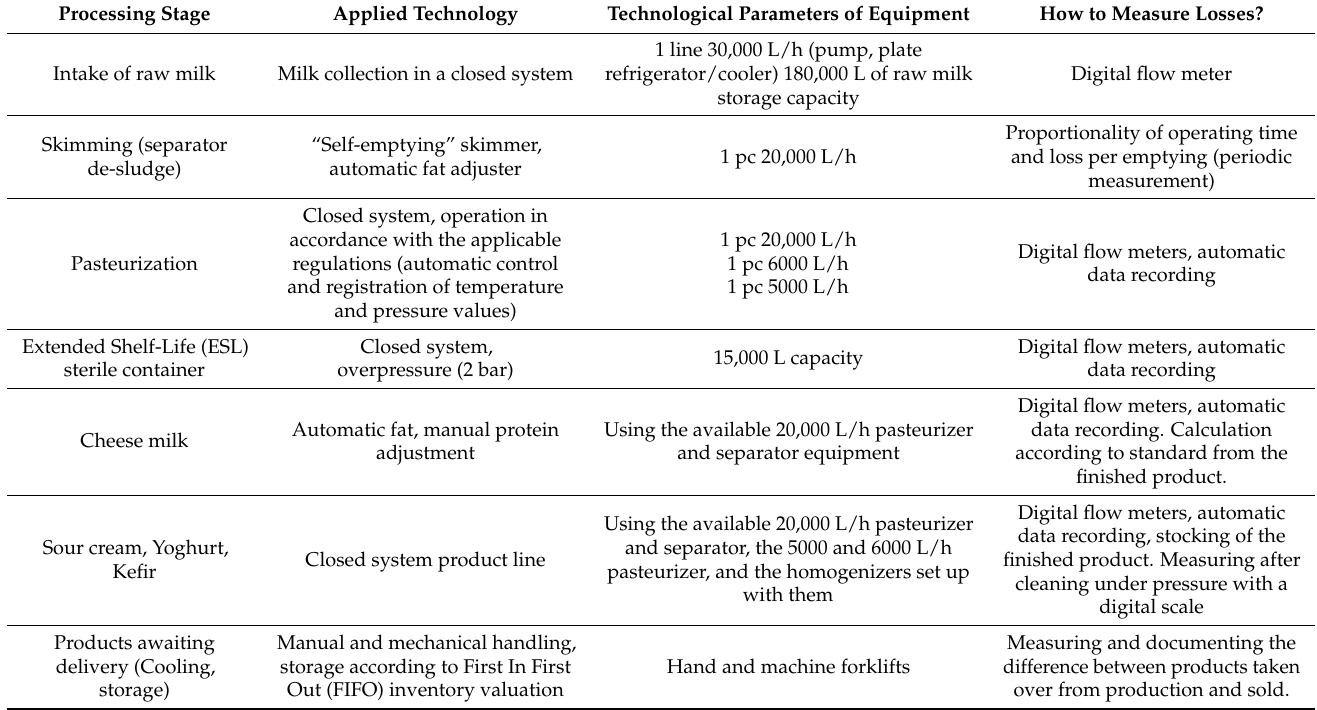
Table 1. Technological parameters of the equipment at stages of processing in the analysed plant.